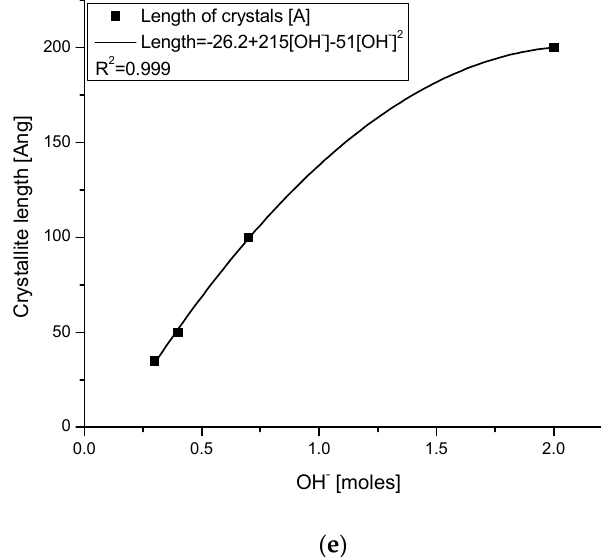
Figure 2. ( a , b ) Relationships between Ca 2+ and Mg 2+ or OH − ions in bioapatites; ( c ) tendency of changes inside bioapatites during transformations; relationship between the length of plate-like crystallites and ( d ) Ca 2+ ion molar contents; ( e ) OH − ion contents. (Letters w, d, b, e, and h mean whitlockite, dentin, bone, enamel, and hydroxyapatite, respectively.) Please notice that the localization of points on the Ca axis corresponds to particular phases of bioapatites.